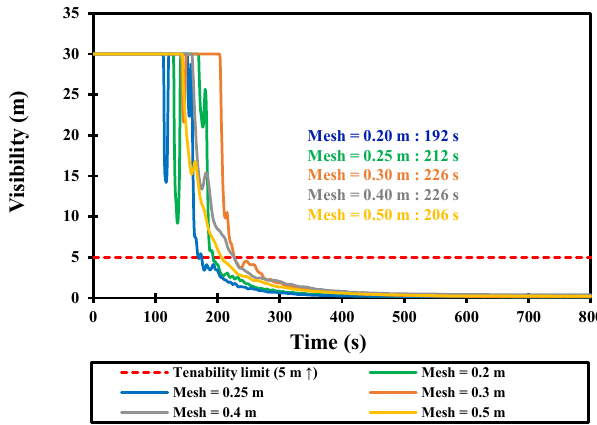
Figure A1. Visibility results according to the mesh size.